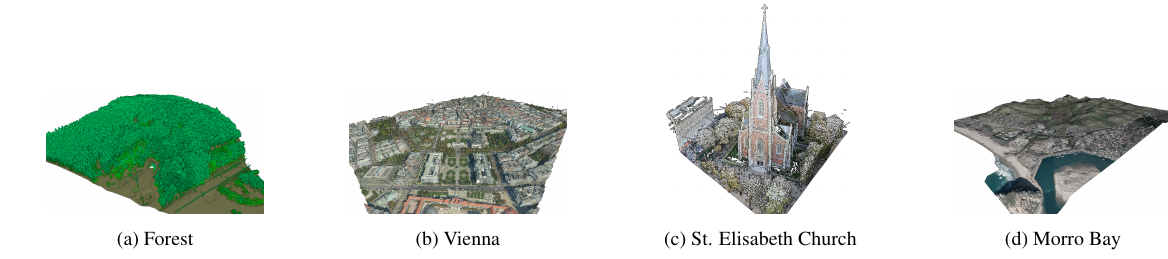
Figure 2. Data sets used in this